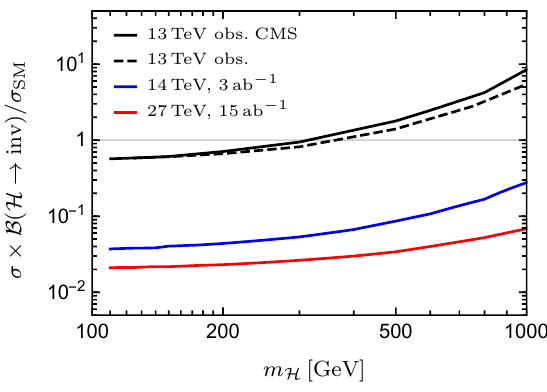
Figure 3 . 95 % CL upper limit on (cid:22) H = (cid:27) (cid:2) B ( H ! inv) =(cid:27) SM for an additional SM-like Higgs boson H that does not mix with the SM Higgs boson as a function of its mass, m H . The black solid curve shows the existing limit from CMS reported in ref. [39] while the black dashed curve shows our limit from the recasting of this search. The blue and red curves show our projected limits for the 14 TeV HL-LHC and 27 TeV HE-LHC,